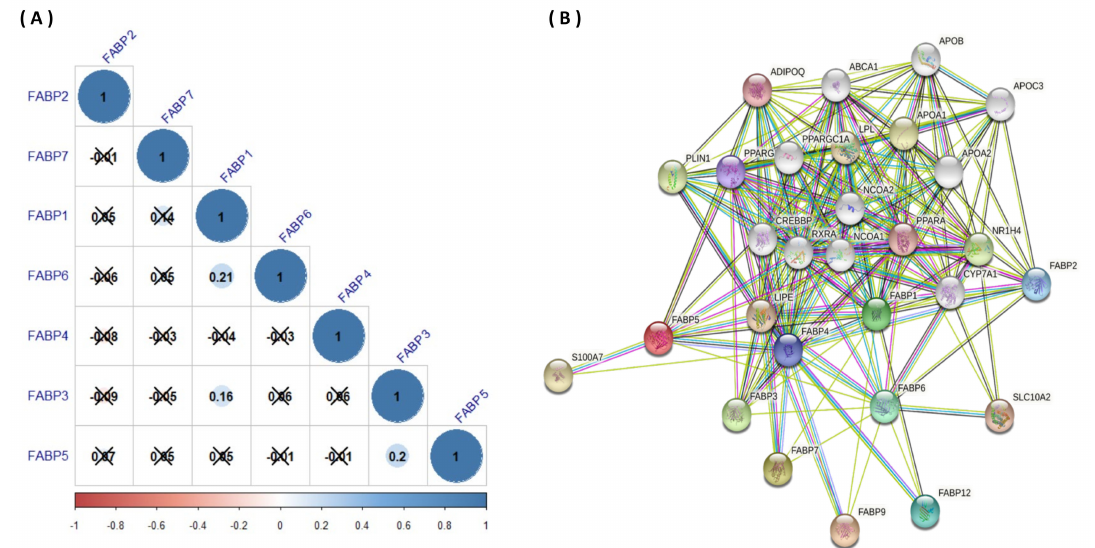
Figure 7. ( A ) Correlation analysis of fatty acid-binding protein ( FABP ) genes in CRC (cBioportal database). Correlation plots among FABP family genes in CRC. Insignificant correlation values are indicated by crosses; p < 0.05 was considered statistically significant. ( B ) Protein–protein interactions (PPIs) of FABP s family members (STRING database). Highly interacting proteins are represented as hub protein nodes in the PPI network. The nodes also show the known or anticipated three-dimensional protein structures. Proteins involved in cell death control are represented by red nodes. Proteins involved in the immune system are represented by green nodes. Proteins involved in neutrophil degranulation are represented by blue nodes. Proteins involved in RNA metabolism are represented by pink nodes. Proteins linked to chromatin DNA binding are represented by yellow nodes. The types of evidence supporting these hypothesized connections are shown by lines of different